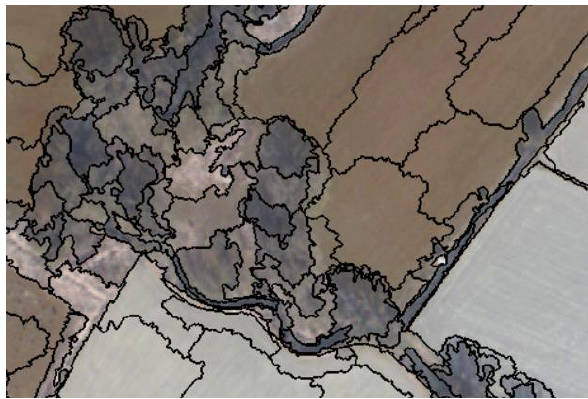
Figure 7. Same portion of the image after segmentation.